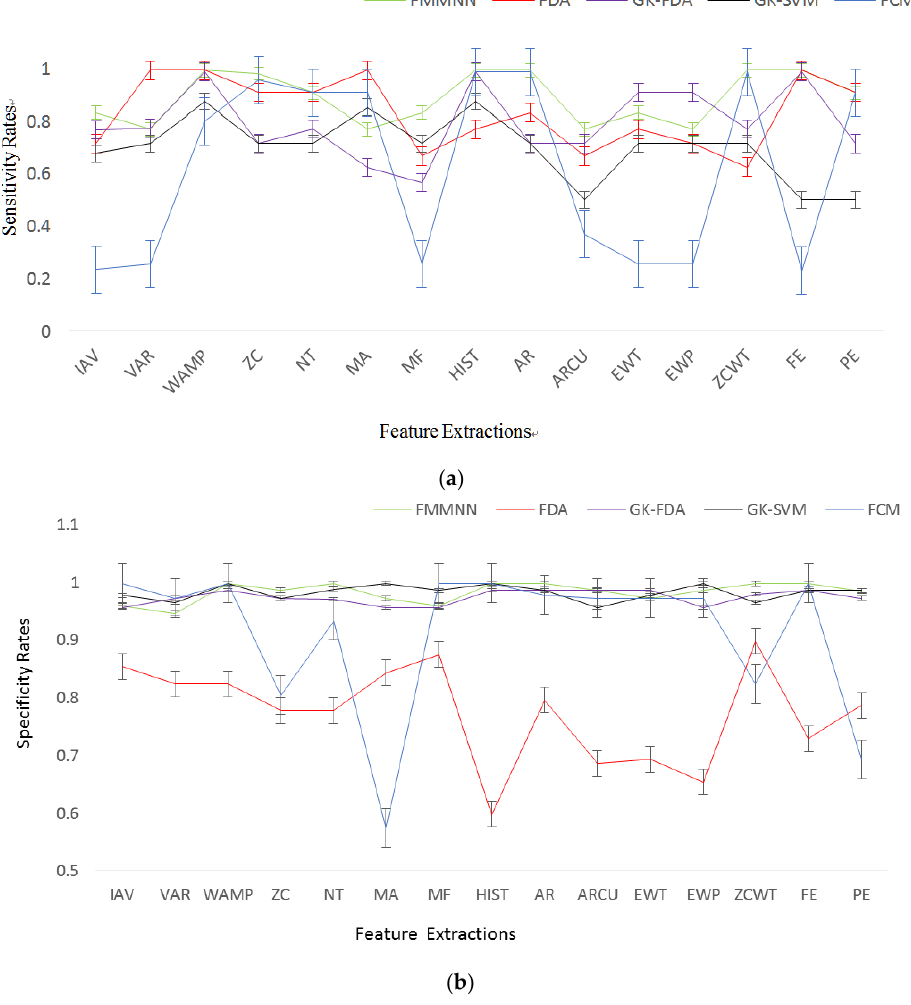
( b ) Figure 10. Sensitivity, Specificity, and recognition accurate rate of two specific feature types. ( a ) Sensitivity, Specificity, and whole recognition rate of WAMP. ( b ) Sensitivity, Specificity, and Recognition Rate of MA. Table 4. Sensitivity, Specificity and Calculation times (%, % and ms). The bold numbers indicate the features with highest Sensitivity and Specificity rate for each classifier. The shaded indicate the classifiers with the highest Sensitivity and Specificity rate for each feature. The zigzag underlines indicate the features with shortest calculation time for each classifier. The straight underlines indicate the classifiers with shortest calculation time for each feature.